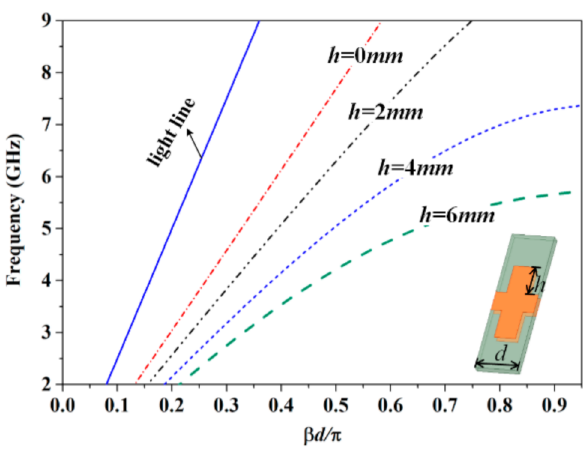
Figure 2. Dispersion diagram of the parallel